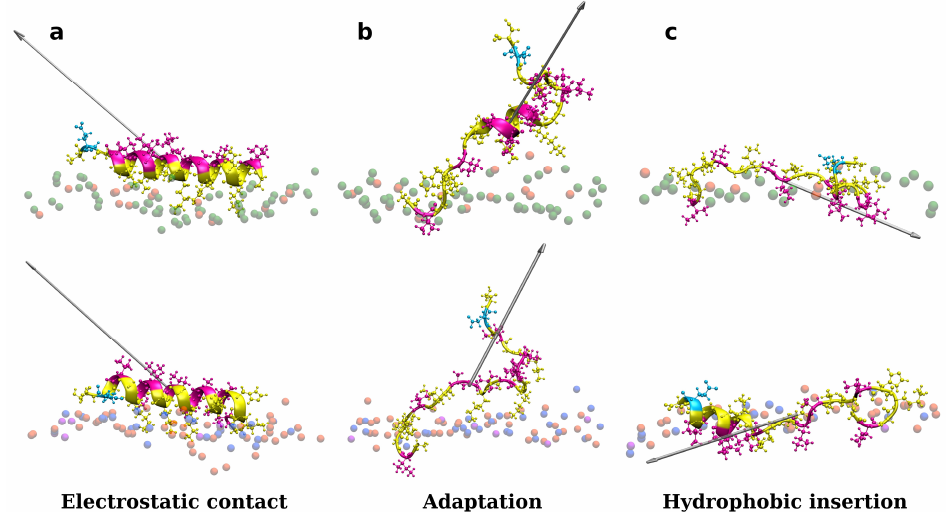
Figure 1. Representations of a single adeptantin-1 interacting with Gram-negative (on the top) and Gram-positive (on the bottom) bacterial membranes, where snapshot ( a ) shows electrostatic bonding of charged residues with upper leaflet lipids, ( b ) depicts peptide conformation change, and ( c ) represents the final state with hydrophobic residues inserted in the membrane interior. The 3D-HM vector is depicted as a grayed arrow, where length of the arrow corresponds to the 3D-HM value (values are in Table S3 in Supplementary Materials). Peptides are depicted as ribbons and spheres, with hydrophobic residues in magenta, polar and positively charged residues in yellow, and negative Glu in cyan. The upper leaflet of the membrane is represented by beads for P atoms that are shown in green for POPE lipids, orange for POPG lipids, blue for Lys-PG lipids, and violet for PVCL2 lipids. For clarity, other atoms and molecules of the membranes, as well as water molecules and ions, are